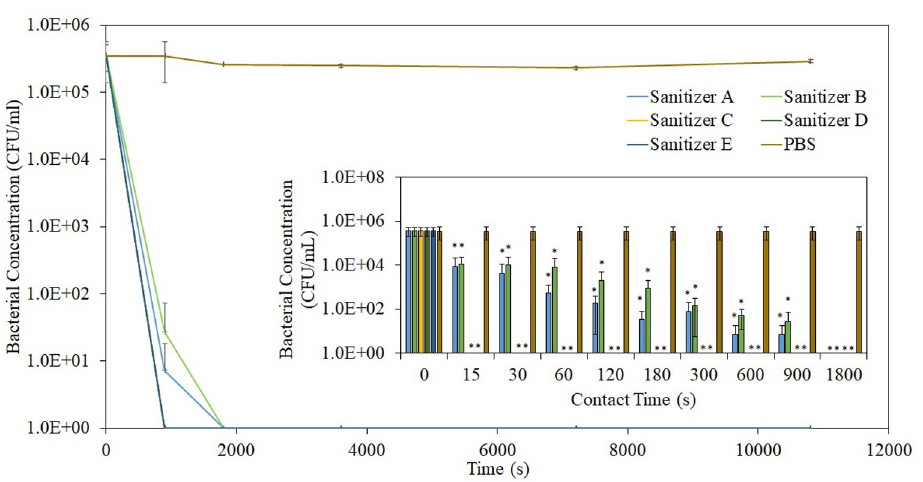
Fig 1. Kinetics of bactericidal activities for different alcohol-based